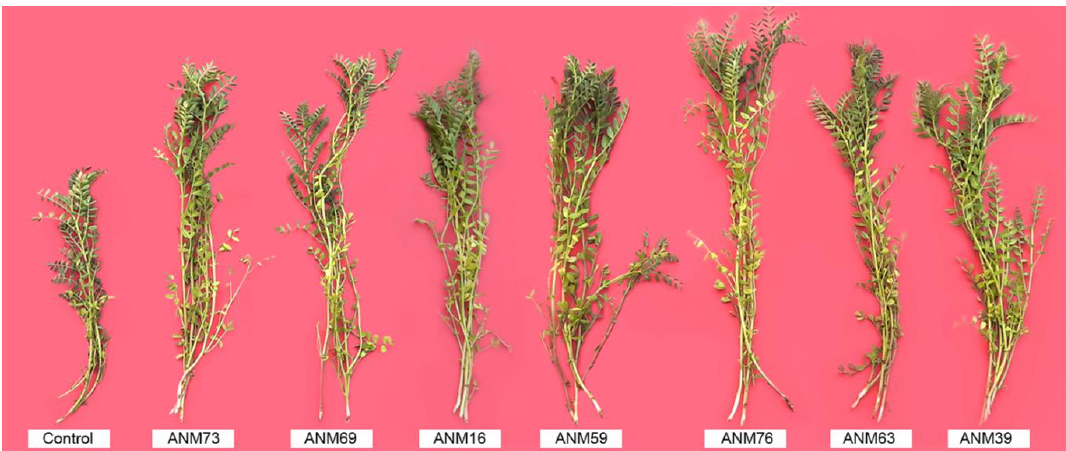
Figure 2. Comparison of shoot growth of chickpea inoculated with endophytic strains grown under the jar trial.